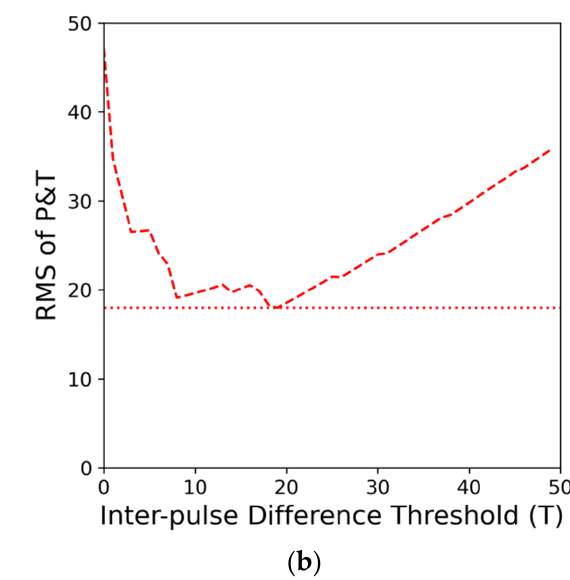
Figure 2. An example of H-index inspired interval irregularity index ( III ) calculation. The resulted III is 18.0. ( a ) Shows the % of samples satisfying different threshold values. ( b ) Shows the quadratic mean of P&T across different thresholds and where the minimum value is located.